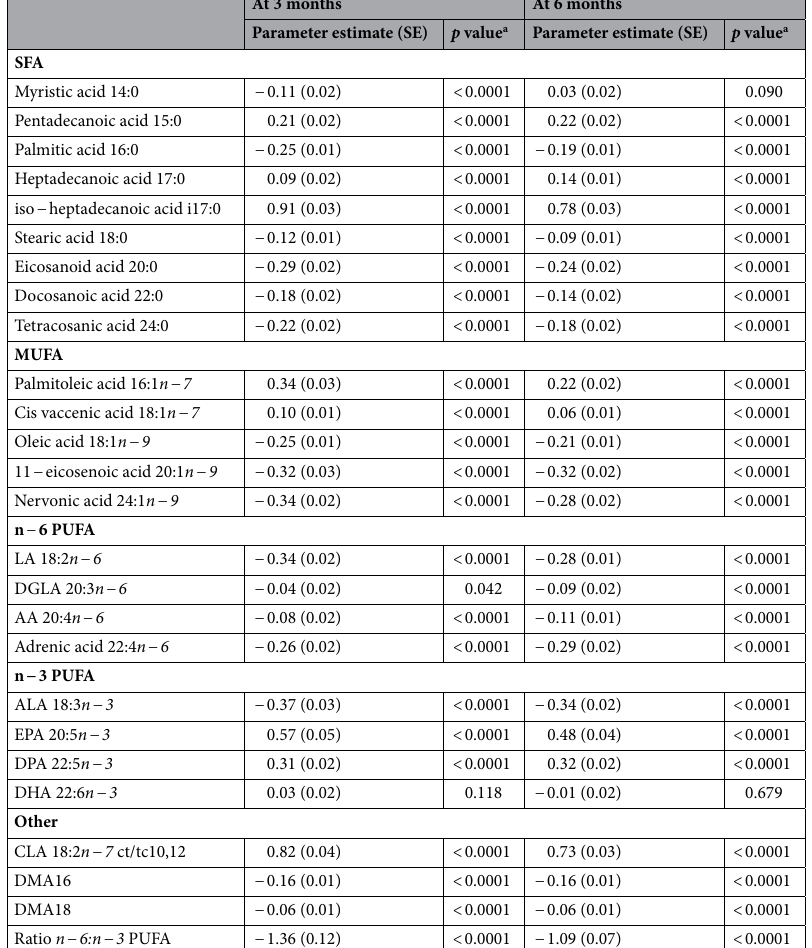
Table 3. The difference between fatty acid status of breastfed and not breastfed children at the age of 3 and 6 months in TEDDY nested case–control study. a The difference between fatty acid status of breastfed and not breastfed children at the age of 3 and 6 month was tested by fitting a linear regression model for CLR transformed fatty acid (except for the ratio of sum n − 6 and sum n − 3), adjusted for case–control